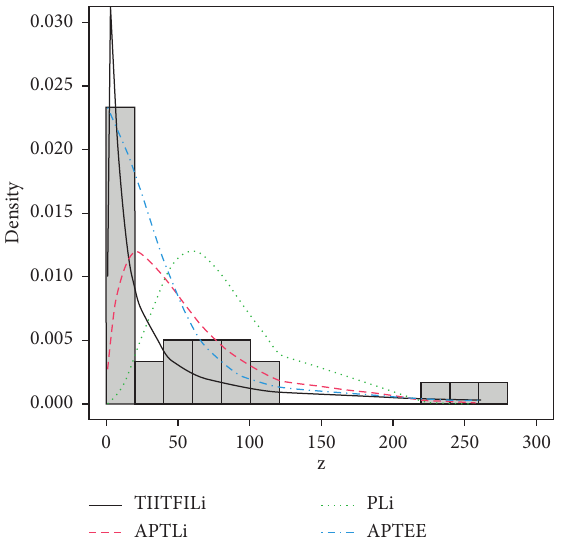
Figure 3: Estimated pdf of the TIITFILi and other competing models for first data.